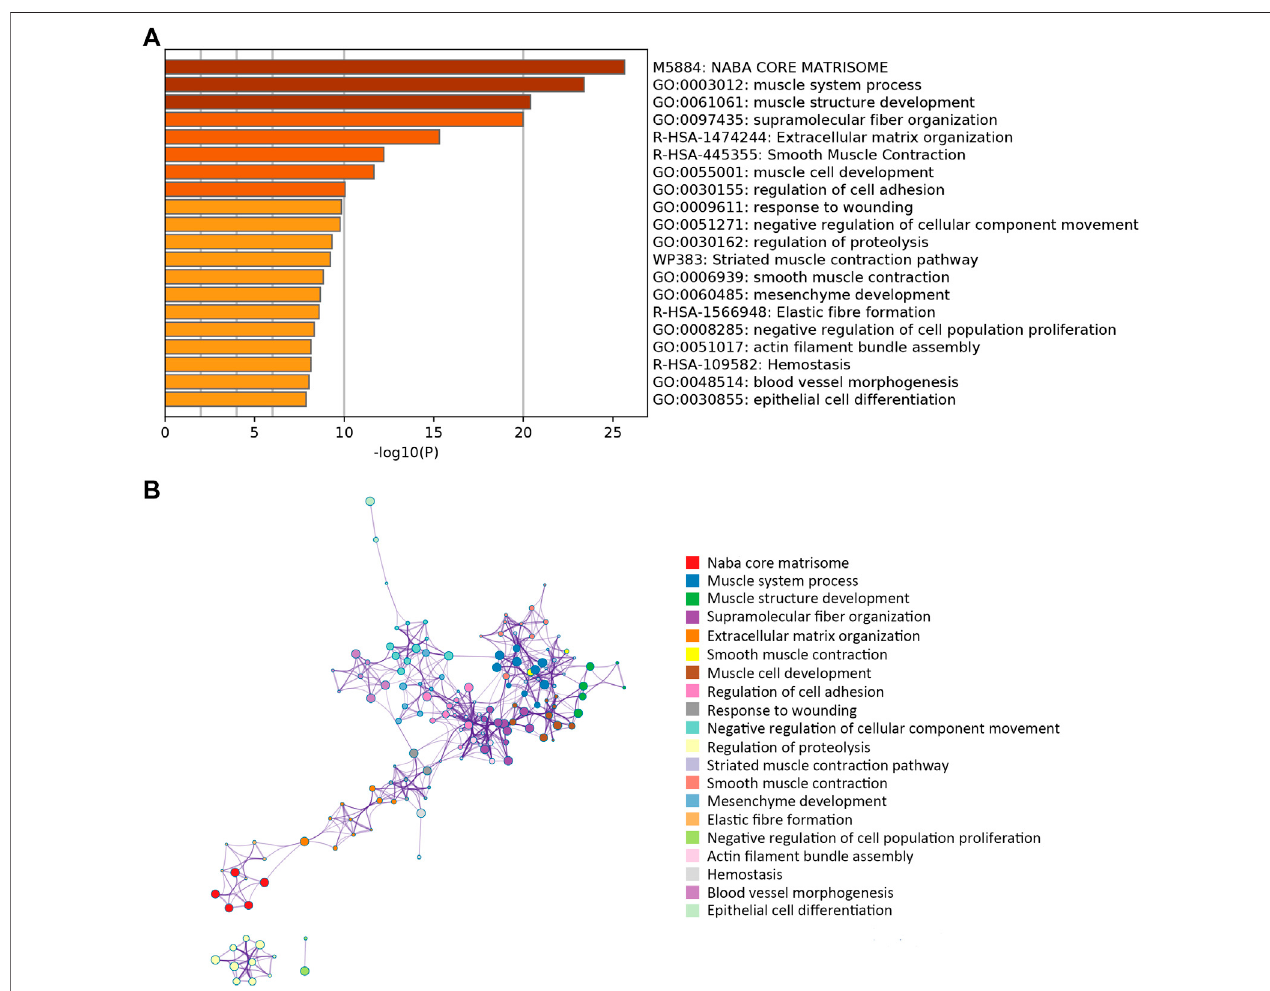
FIGURE 2 | (A) Bar plot illustrating which functions or pathways DEGs were enriched by Metascape tools. (B) The term-enriched network was colored by cluster ID, where nodes sharing the same cluster ID are usually close to each other.